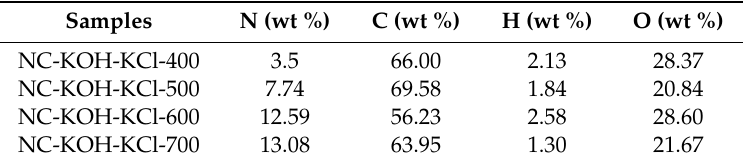
Table 4. BET surface area and porosity of samples carbonized at different temperatures.